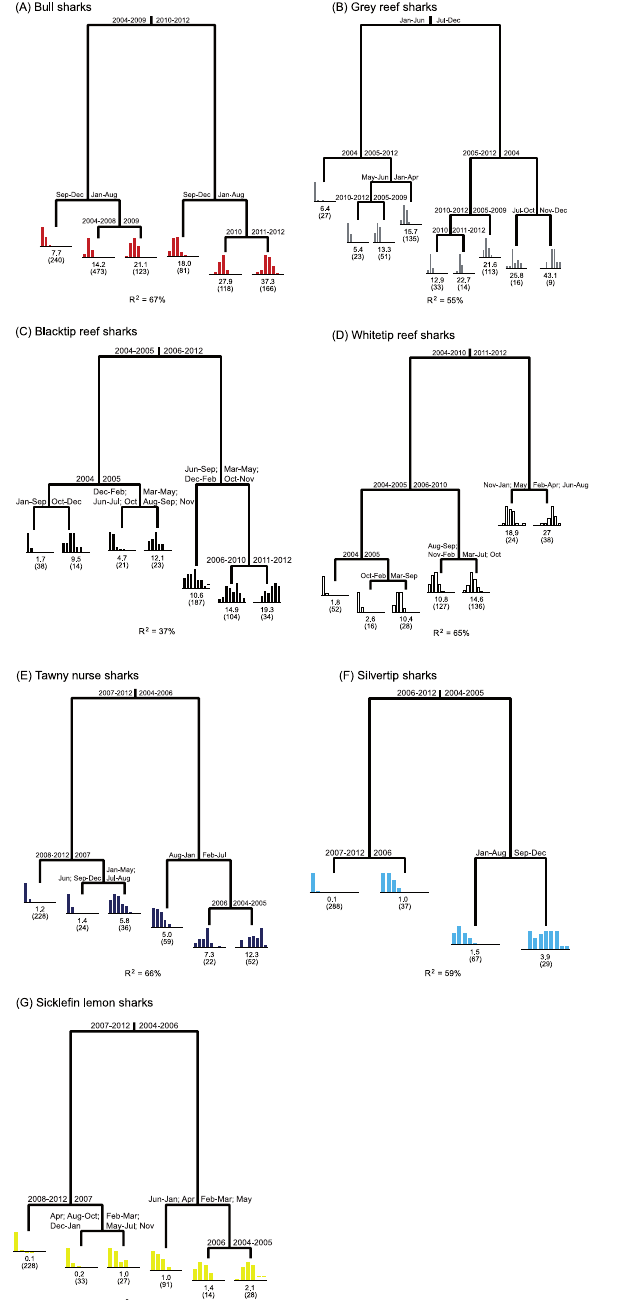
Figure 5. Classification and regression trees explaining shark relative abundance based on year and month. For C. leucas , trees were constructed using the number of individuals sighted per day. For the remaining species, due to the often low numbers, analyses were done based on the number of sharks detected per 3-day blocks, after the days within each month were placed in a random order. Histograms of distribution of relative abundance are presented below the terminal nodes, and mean number and sample size (in brackets) are also indicated.